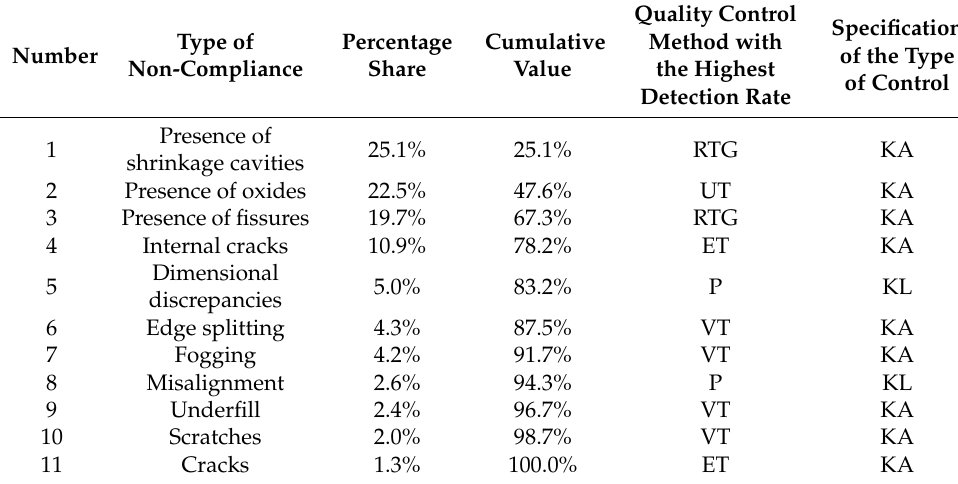
Table 1. Non-conformities identified during the period under review.